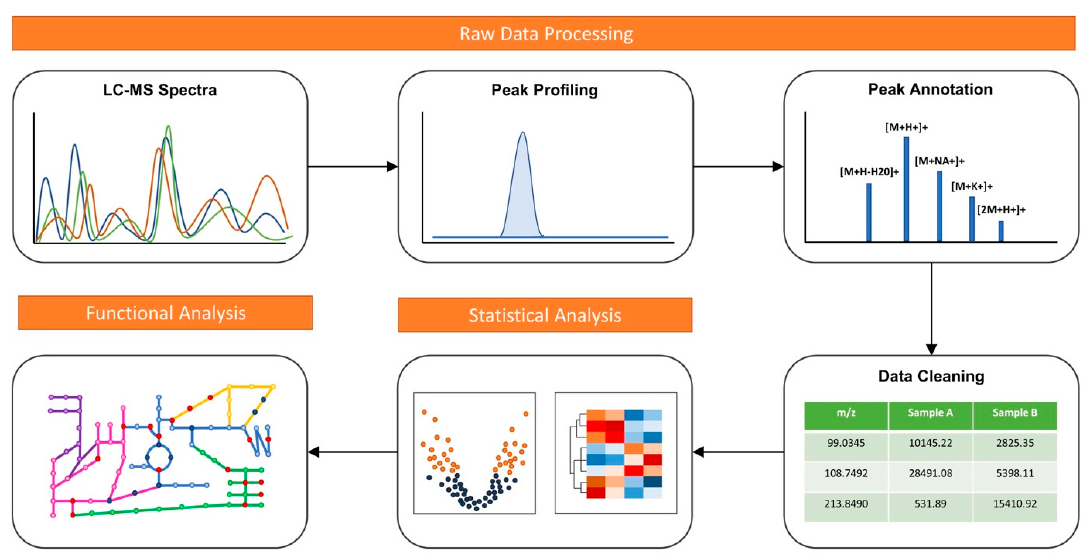
Figure 1. A typical metabolomics data analysis workflow including raw data processing, statistical analysis and functional interpretation.